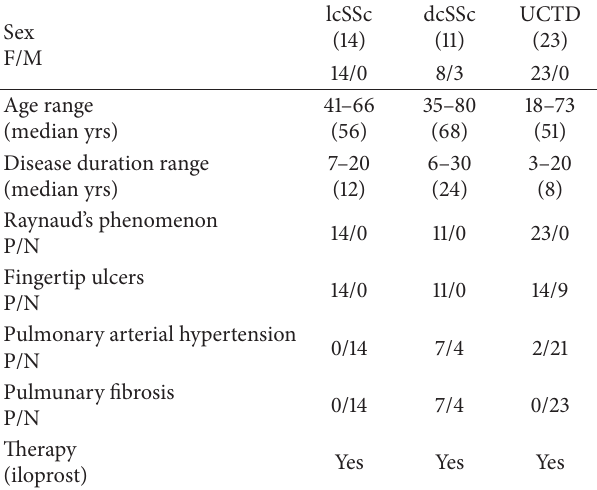
Table 1: Clinical and demographic characteristics of patients.